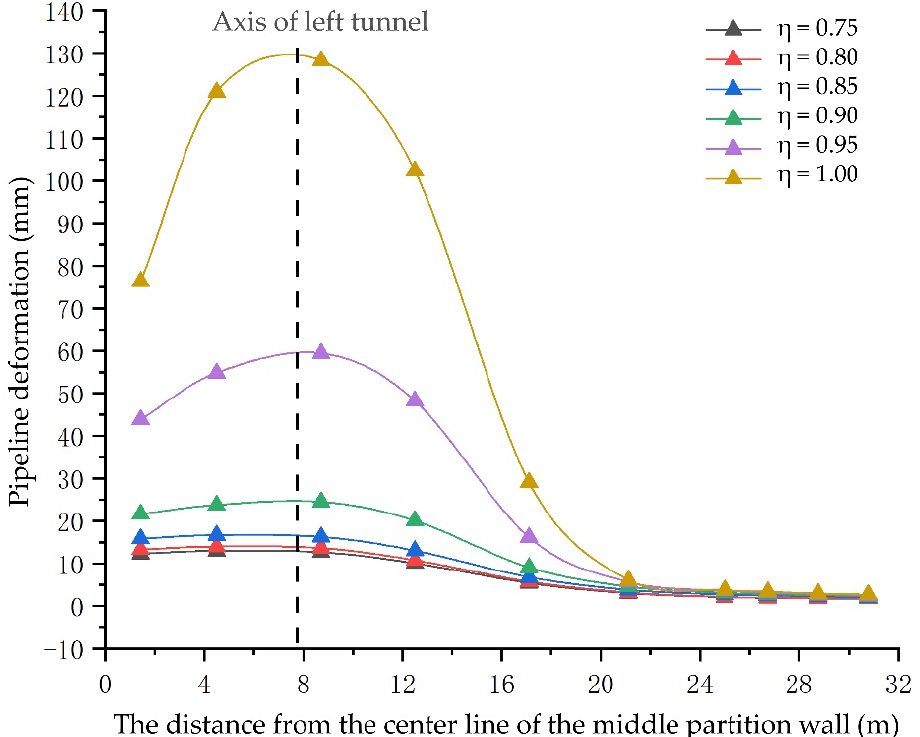
Figure 23. Pipeline deformation.